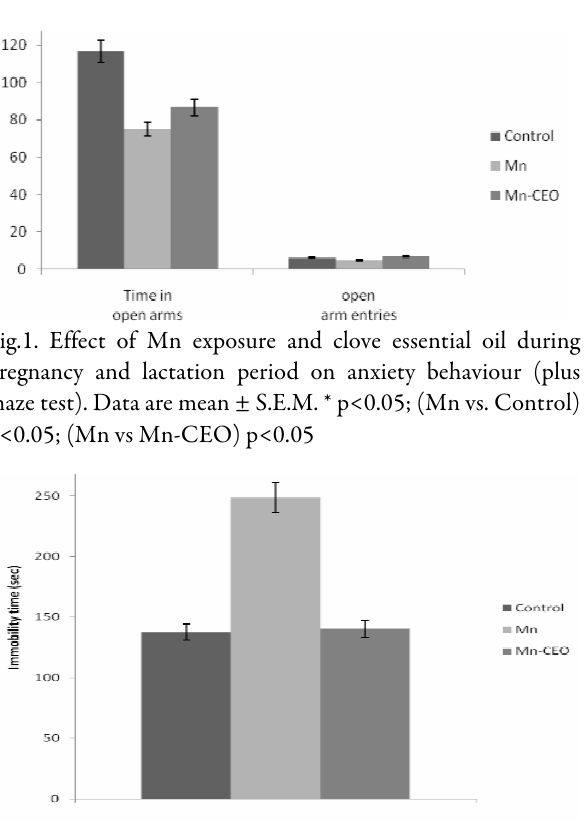
et al ., 2011 ; Oszlánczi et al ., 2010).